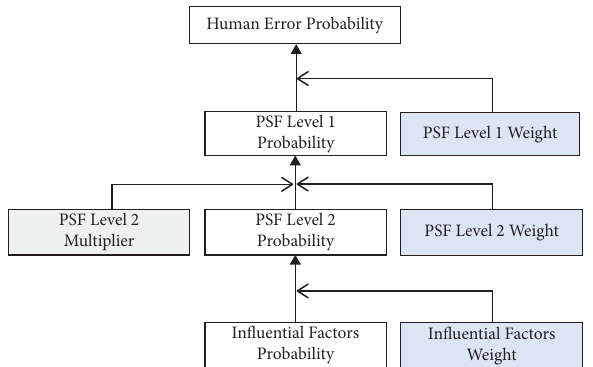
Figure 1: Linkage model of factors in the model for deriving